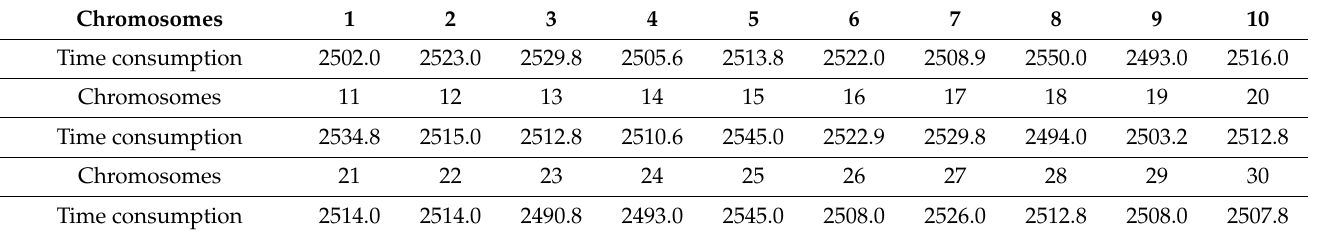
Table 4. The total time consumption of each chromosome after iteration.